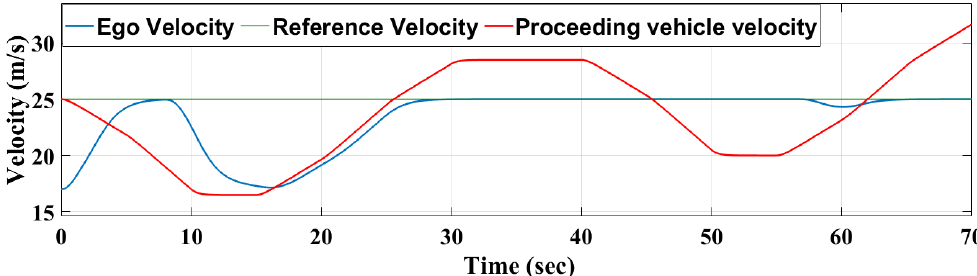
Figure 15. Relative distance compared to safety distance—MPC controller.